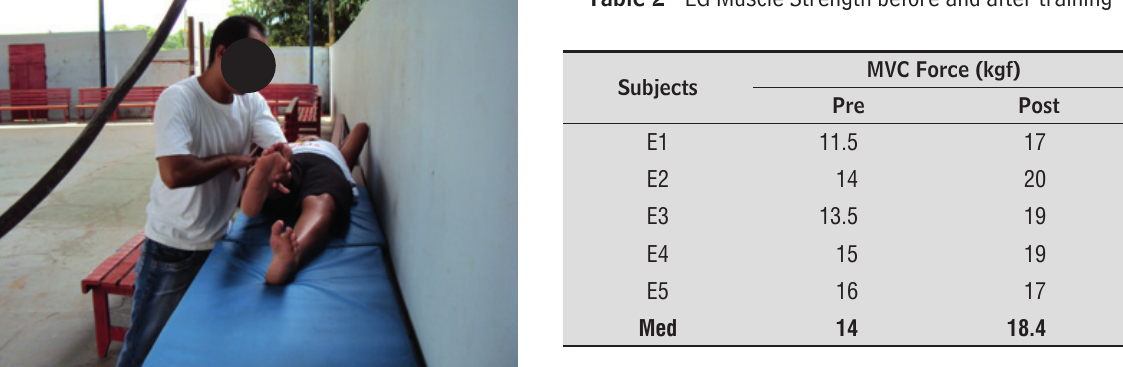
Figure 1 - FNP-based training, held at